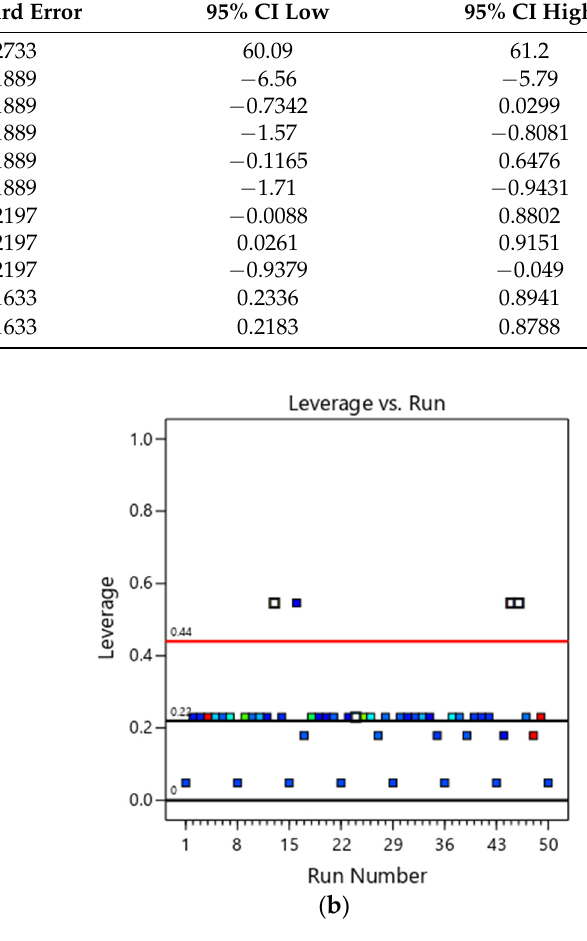
Figure 7. Rc,24 h: ( a ) Cook’s distance and ( b ) leverage.